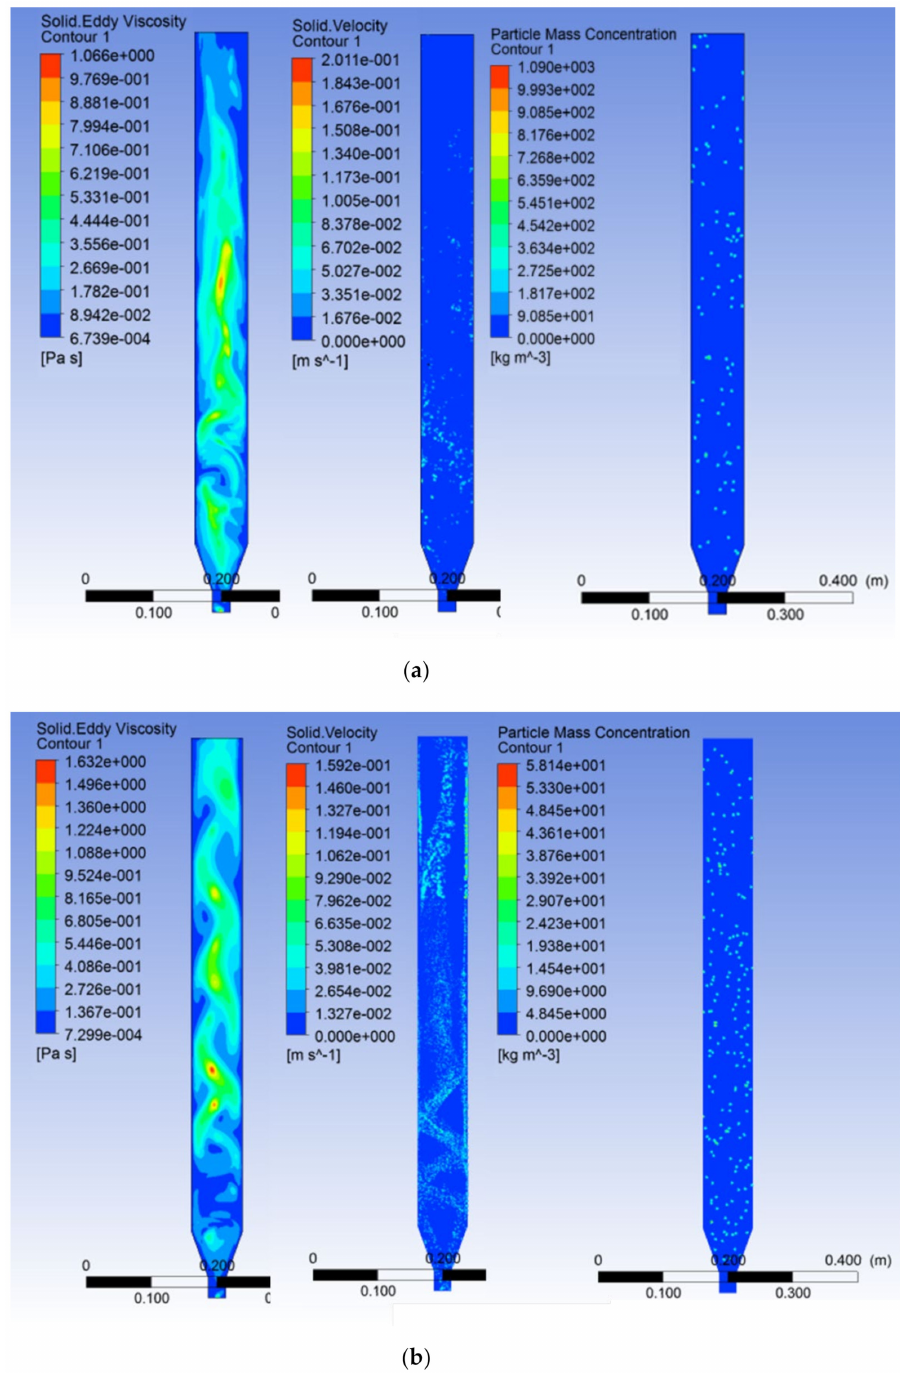
Figure 7. Solid eddies, velocities, and particle mass concentration contours over the three regions ( a ) at 0.5 m/s feed gas velocity, 0.003 m orifice diameter, 0.25 m gas head, 0.018 m mixing particle diameter, and 0.04 kg total mixing particle mass and ( b ), with a feed gas velocity of 1.5 m/s, an orifice diameter of 0.001 m, a gas head of 0.202 m, a mixing particle diameter of 0.0107 m, and a total mass of 0.02